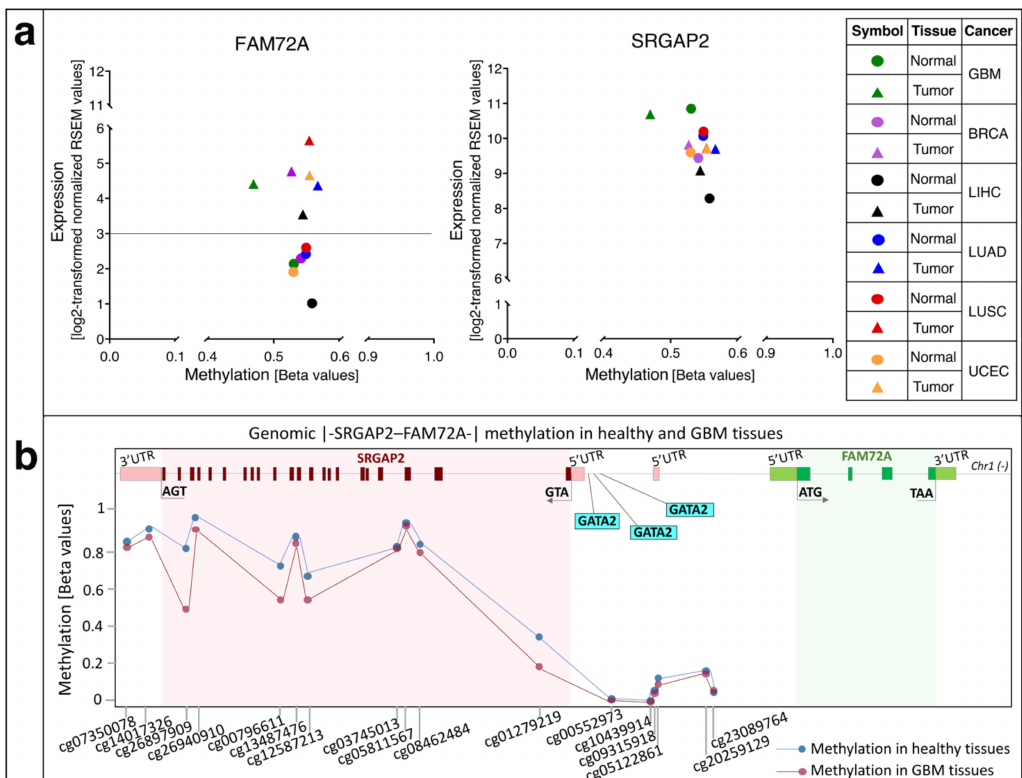
Figure 8. ( a ) Comparison between methylation status and expression levels of FAM72A and SRGAP2 across normal and tumor tissues in GBM, breast, lung, uterine, and liver cancers. Mean methylation beta values were plotted against mean RNA-sequencing by expectation-maximization (RSEM) expression values (log2-transformed normalized RSEM values). Circles indicate normal tissues and triangles indicate cancer tissues. Green symbols indicate GBM data, purple symbols indicate breast invasive carcinoma data, black symbols indicate liver hepatocellular carcinoma data, blue symbols indicate lung adenocarcinoma data, red symbols indicate lung squamous cell carcinoma data, and orange symbols indicate uterine corpus endometrial carcinoma data. In the case of FAM72A, the differences in methylation status between normal and cancer tissues vary among GBM, breast, and liver cancer, where less methylation leads to a two-fold difference in FAM72A expression in cancer tissues. Methylation status between normal and cancer tissues is similar in lung and uterine cancer tissues. In the case of lung tissues, the cancer samples show higher FAM72A expression and a higher methylation status as well, indicating that the FAM72A promoter methylation alone may not be responsible for its increased expression